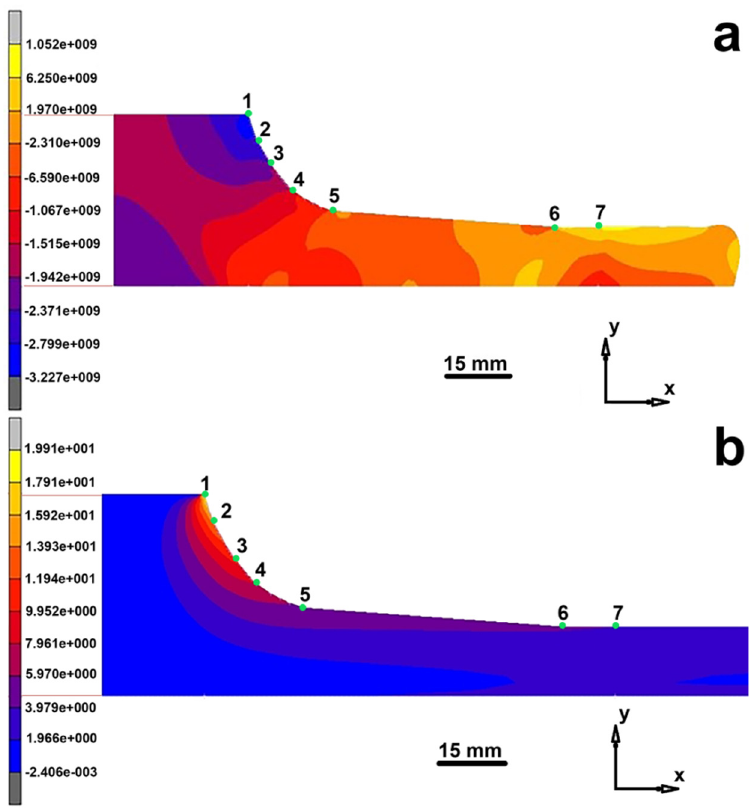
Figure 5. Distribution of main maximum stresses ×10 7 MPa ( a ) and total maximum strains for extrusion of 30 mm diameter rod ( b ).